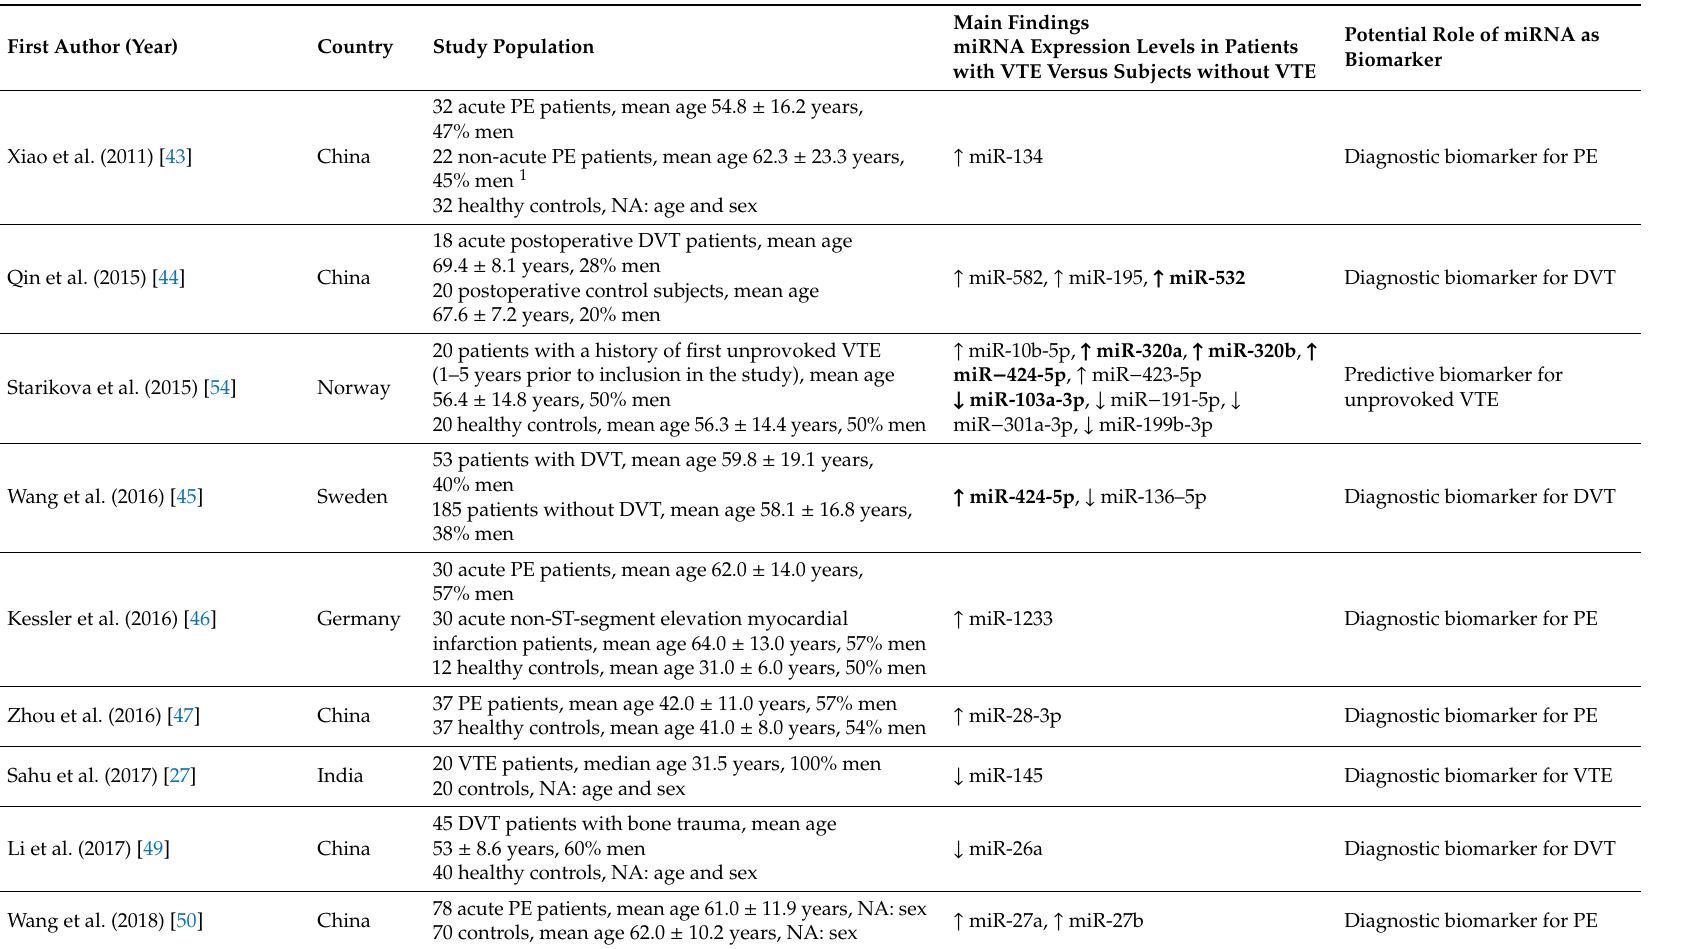
Table 2. Epidemiological studies on microRNAs (miRNAs) and venous thromboembolism